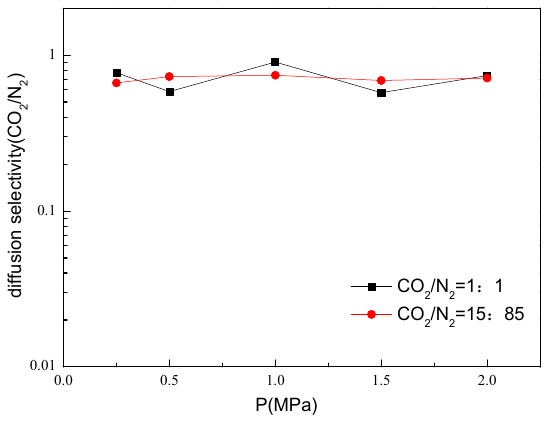
Figure 9. The diffusion selectivities for equimolar and 15:85 binary gas mixtures of CO 2 /N 2 as a function of total bulk pressure in bio-MOF-11.